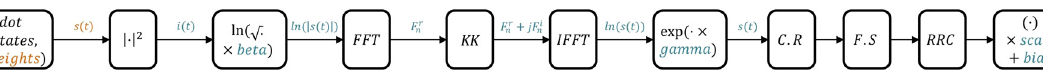
Figure 4: Readout pipeline including receiver blocks, where orange is used for the optical domain and blue for the electronic. Operations – dot, dot product of readout states and optical weights; | · | 2, photodetector squaring; ln, natural logarithm; FFT, fast fourier transform; KK, KK relations in frequency domain where frequency coefficients for f > 0 are doubled and those for f < 0 are zeroed; IFFT, inverse fast fourier transform; exp, exponential; C.R, DC carrier removal; F.S, frequency shifting to the baseband; RRC, root-raised cosine filter; scaling and , frequency shifting for constellation alignment signals – s ( t ), complex optical readout signal; i ( t ), current; ln ( | s ( t ) | ), real part of eq. (6); F r ( ) n , frequency coeffecients of the imaginary signal j 𝜑 ( t ); ln , retreived complex signal as in coefficients of the real signal ln ( | s ( t ) | ); F i s ( t ) n eq . (6); s ( t ), electronic reconstruction of the optical s( t ). Trainable parameters – weights: complex optical weights; beta, gamma: electronic nonlinearity weights; scale, bias: electronic aligning